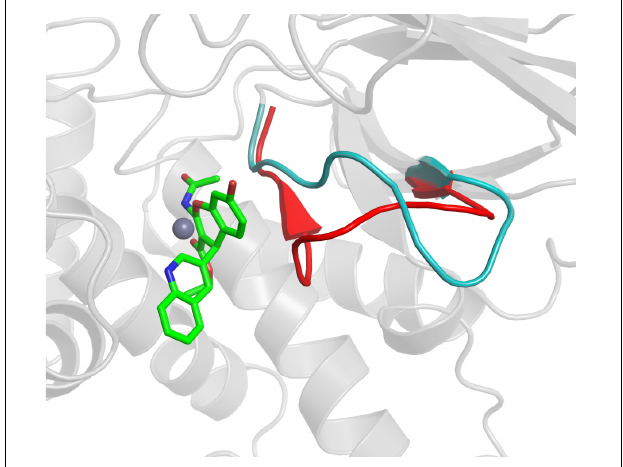
FIGURE 7 | The GAMEN loop in the closed conformation (red color cartoon, PDB ID: 5MJ6) is compared with the GAMEN loop of open conformation (cyan color cartoon, PDB ID: 4PJ6) while compound 9 (green sticks) is docked in the active site. Zn 2 + ion shown as gray